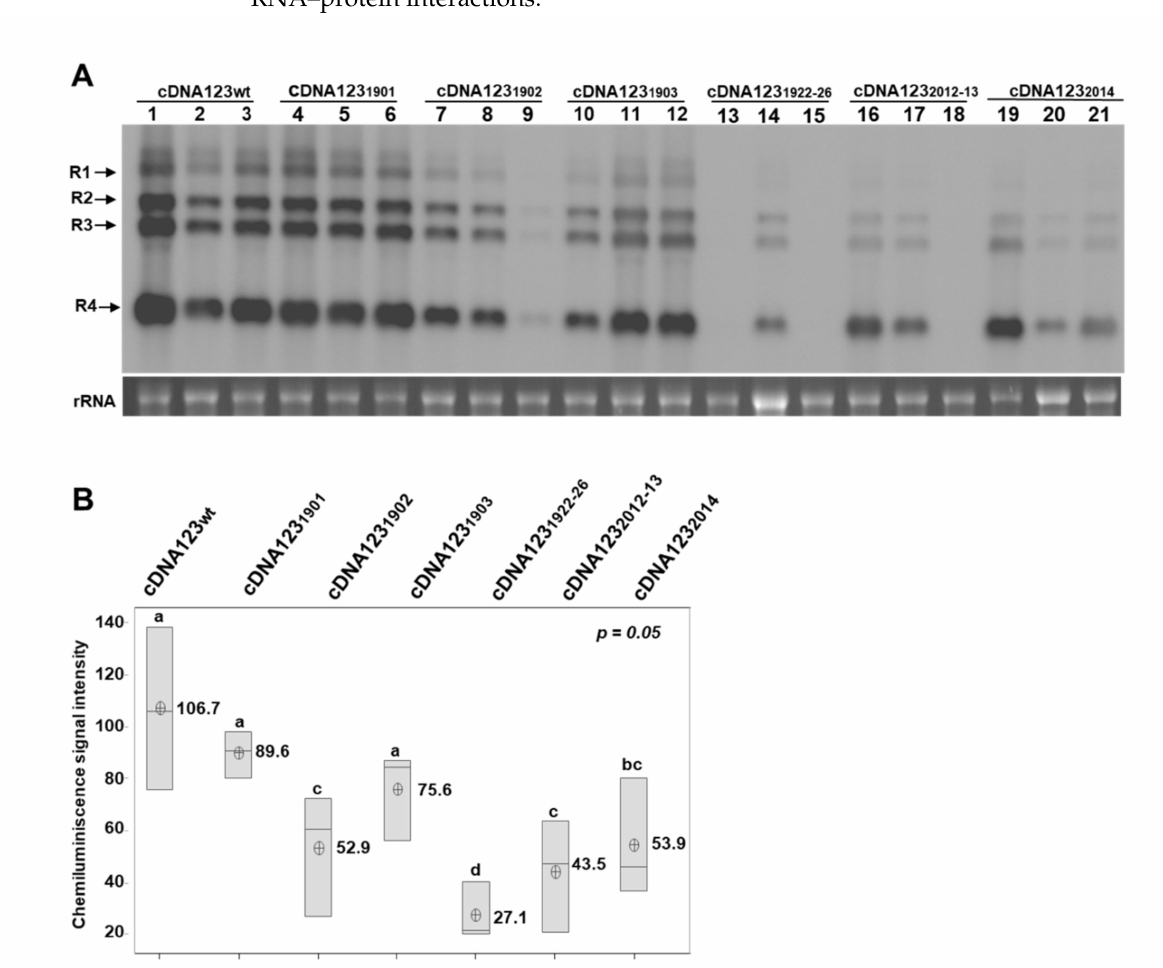
Figure 2. Effect of mutations in DRACH motifs of the 3 (cid:48) UTR-RNA 3, using the agroinfiltration proce- dure. ( A ): Representative Northern blot assays from upper non-infiltrated leaves of N. benthamiana plants, at 5 days post-agroinfiltration. Three plants were agroinfiltrated with different mixtures of cDNAs (indicated at the top of the panels). Positions of the vRNAs are indicated on the left. Ethidium bromide of ribosomal RNAs was used as RNA loading control. ( B ): Boxplots of the densitometric analysis of AMV vRNAs accumulation. The lower and upper limits of the boxes plot the min and max values, respectively, whereas the lines dividing them represent the median values. Points inside boxes represent the mean from the three replicates. p < 0.05 indicates statistical significance. Means that do not share a letter are significantly